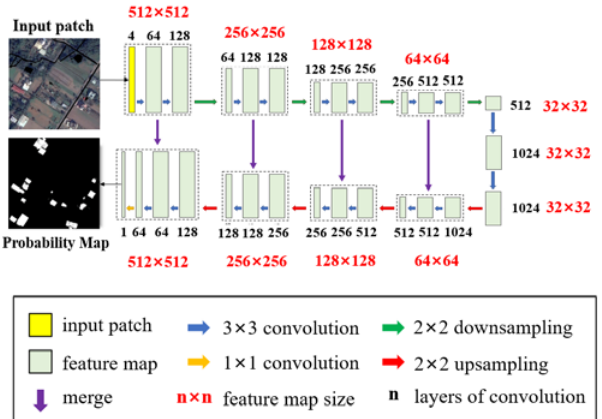
Figure 1 . ENVINet5